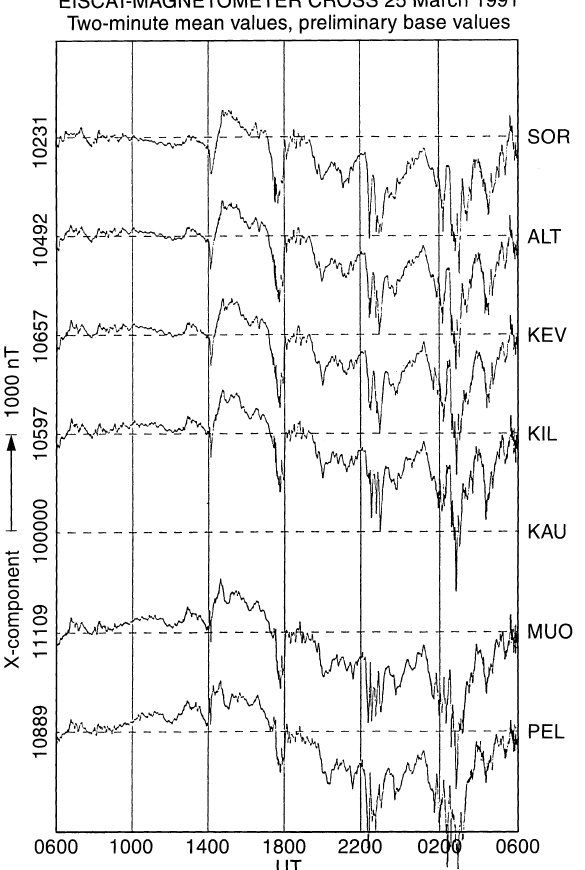
Fig. 8. EISCAT magnetometer data (geographic X -component) on 23–25